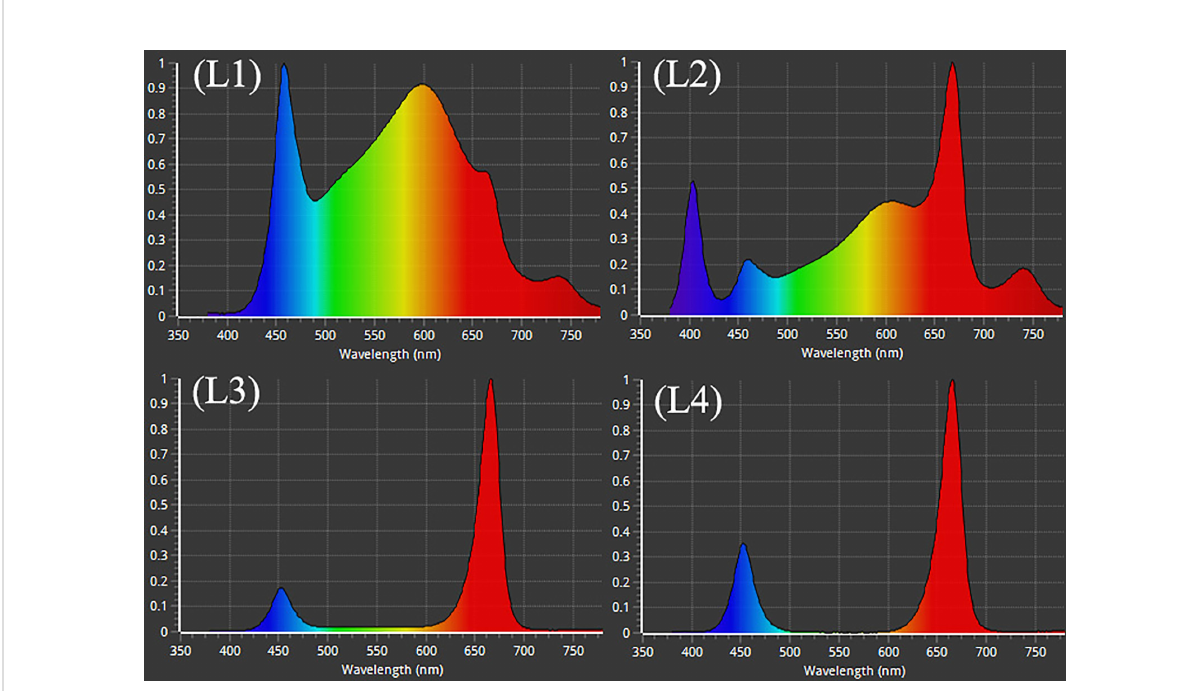
FIGURE 1 Different LED light used in the study. L1, MW 240 (Red 35% + Blue 25% + Green 40%); L2, FS 240-UV (Red 40% + UVA and Blue 26% + Green 29% + Far red 5%); L3, MB 240 (Red 85% + Blue 15%); L4, PF 240 (Red 70% + Blue